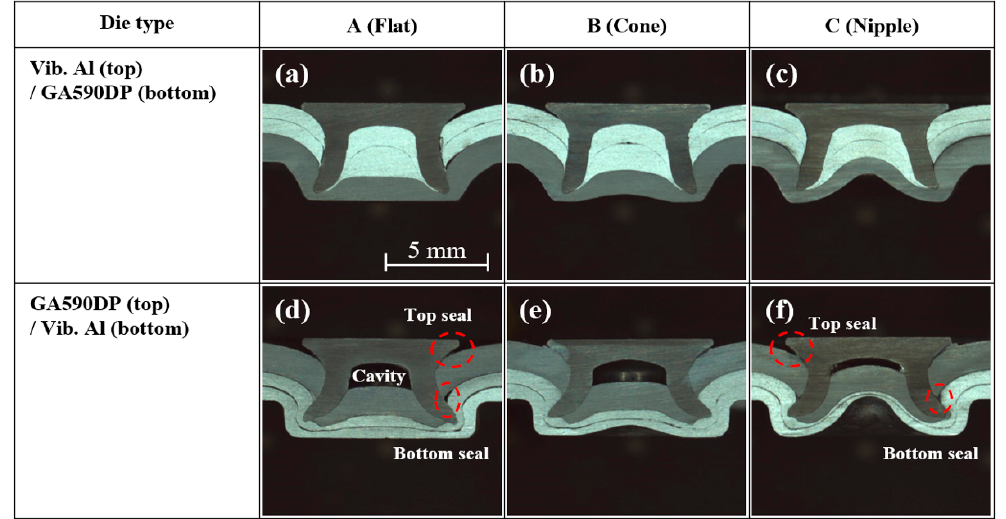
Figure 9. Cross-sectional images for the self-piercing riveted joint formed between the vibration-damping Al and GA590DP with respect to SPR die type and panel configuration: ( a , d ) die type A , ( b , e ) die type B , and ( c , f ) die type C .